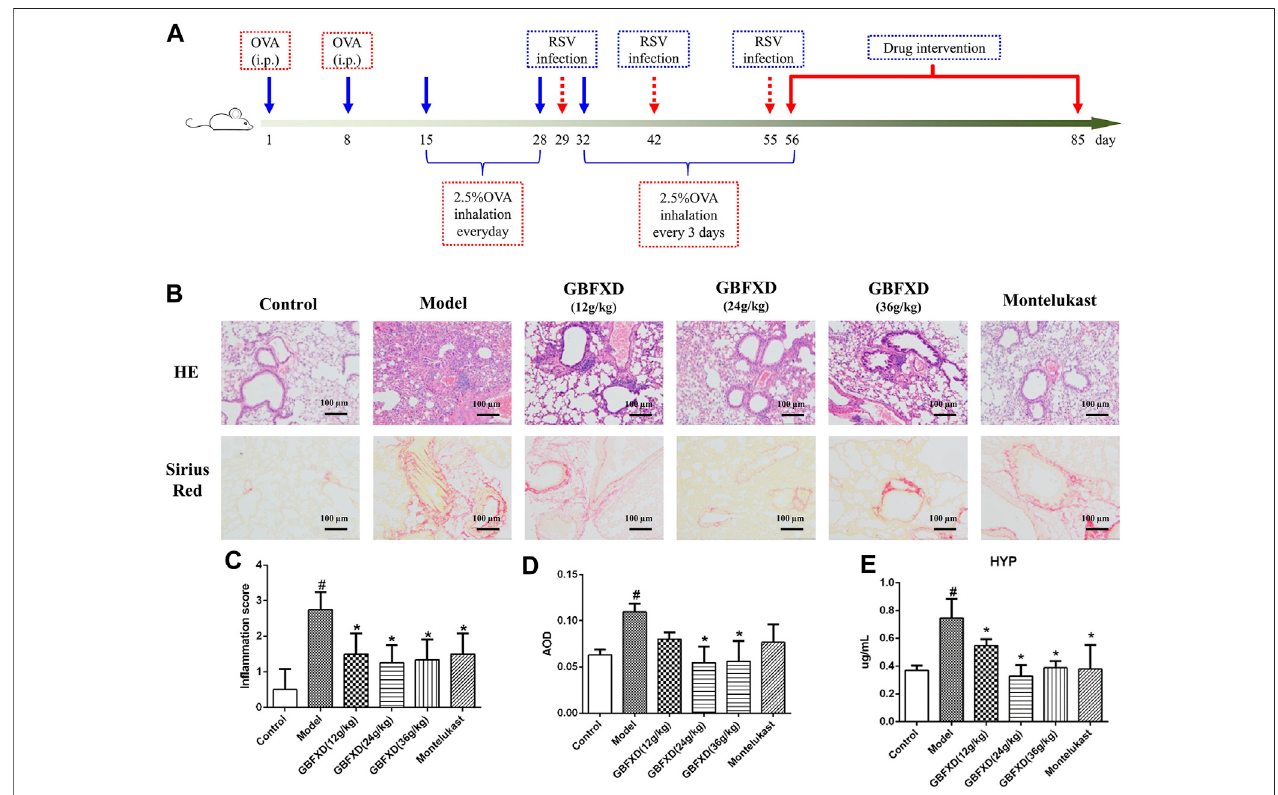
FIGURE 2 | Effect of GBFXD on airway in fl ammation by hematoxylin and eosin (HE) staining, remodeling by Sirius red staining and HYP levels. (A) Experimental protocol to establish the murine OVA-RSV induced CRA murine model and the treatment strategy. (B) HE staining examined in fl ammatory in fi ltration and Sirius red staining identi fi ed collagen deposition ( × 200), Scale bar: 100 μ m. (C – D) Total in fl ammation scores and the quanti fi cation of Sirius red staining by AOD in each group mice. (E) The HYP levels in lung of each group mice measured by ELISA. Values are presented as mean ± SD ( n (cid:2) 3 or 4 mice per group). # p < 0.05 compared to control group, and * p < 0.05 compared to model